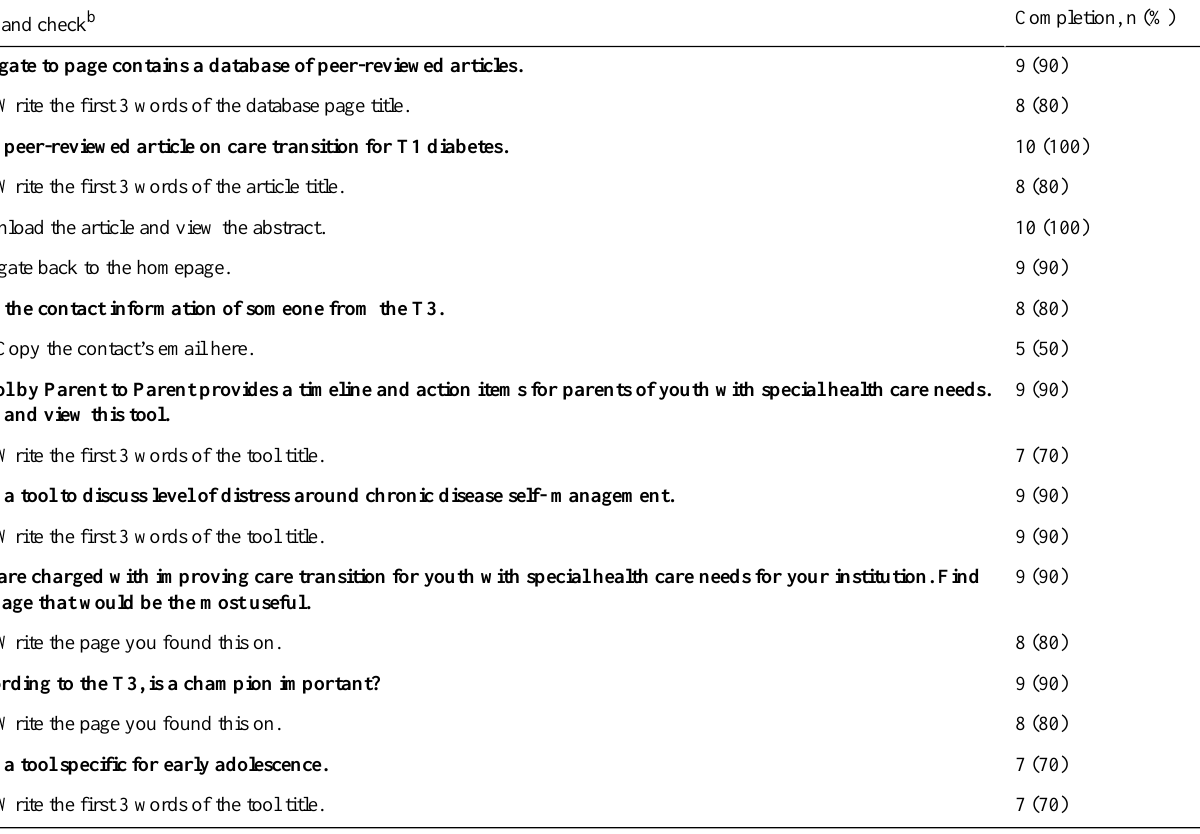
Table 3. Participant (n=10) task performance and associated quality checks.